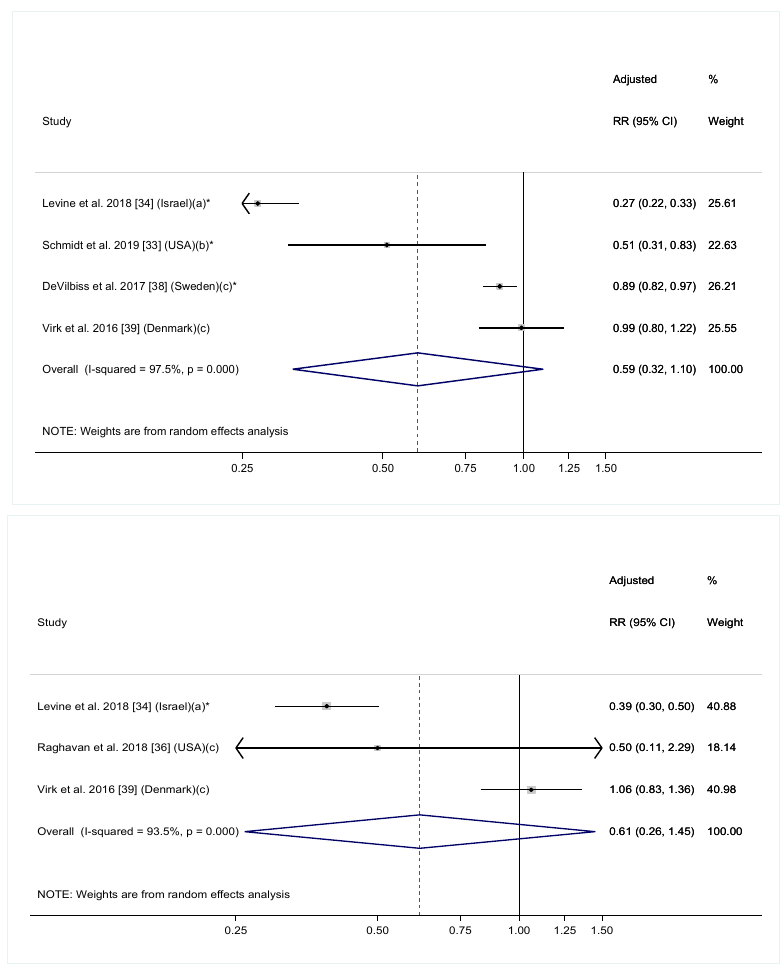
Figure 4. Adjusted odds ratios (ORs) of offspring risk of ASD associated with maternal intake of supplement containing folic acid, multivitamin or prenatal vitamin during (top) and before (bottom) pregnancy. The overall effect size was estimated using random effects models weighted by inverse variance of each study. Notes: (a) Intake of supplement containing folic acid vs. no; (b) Folic acid intake ≥ 600 mcg/day vs. <600 mcg/day; (c) Intake of multivitamin vs. never/rarely. * p < 0.05.